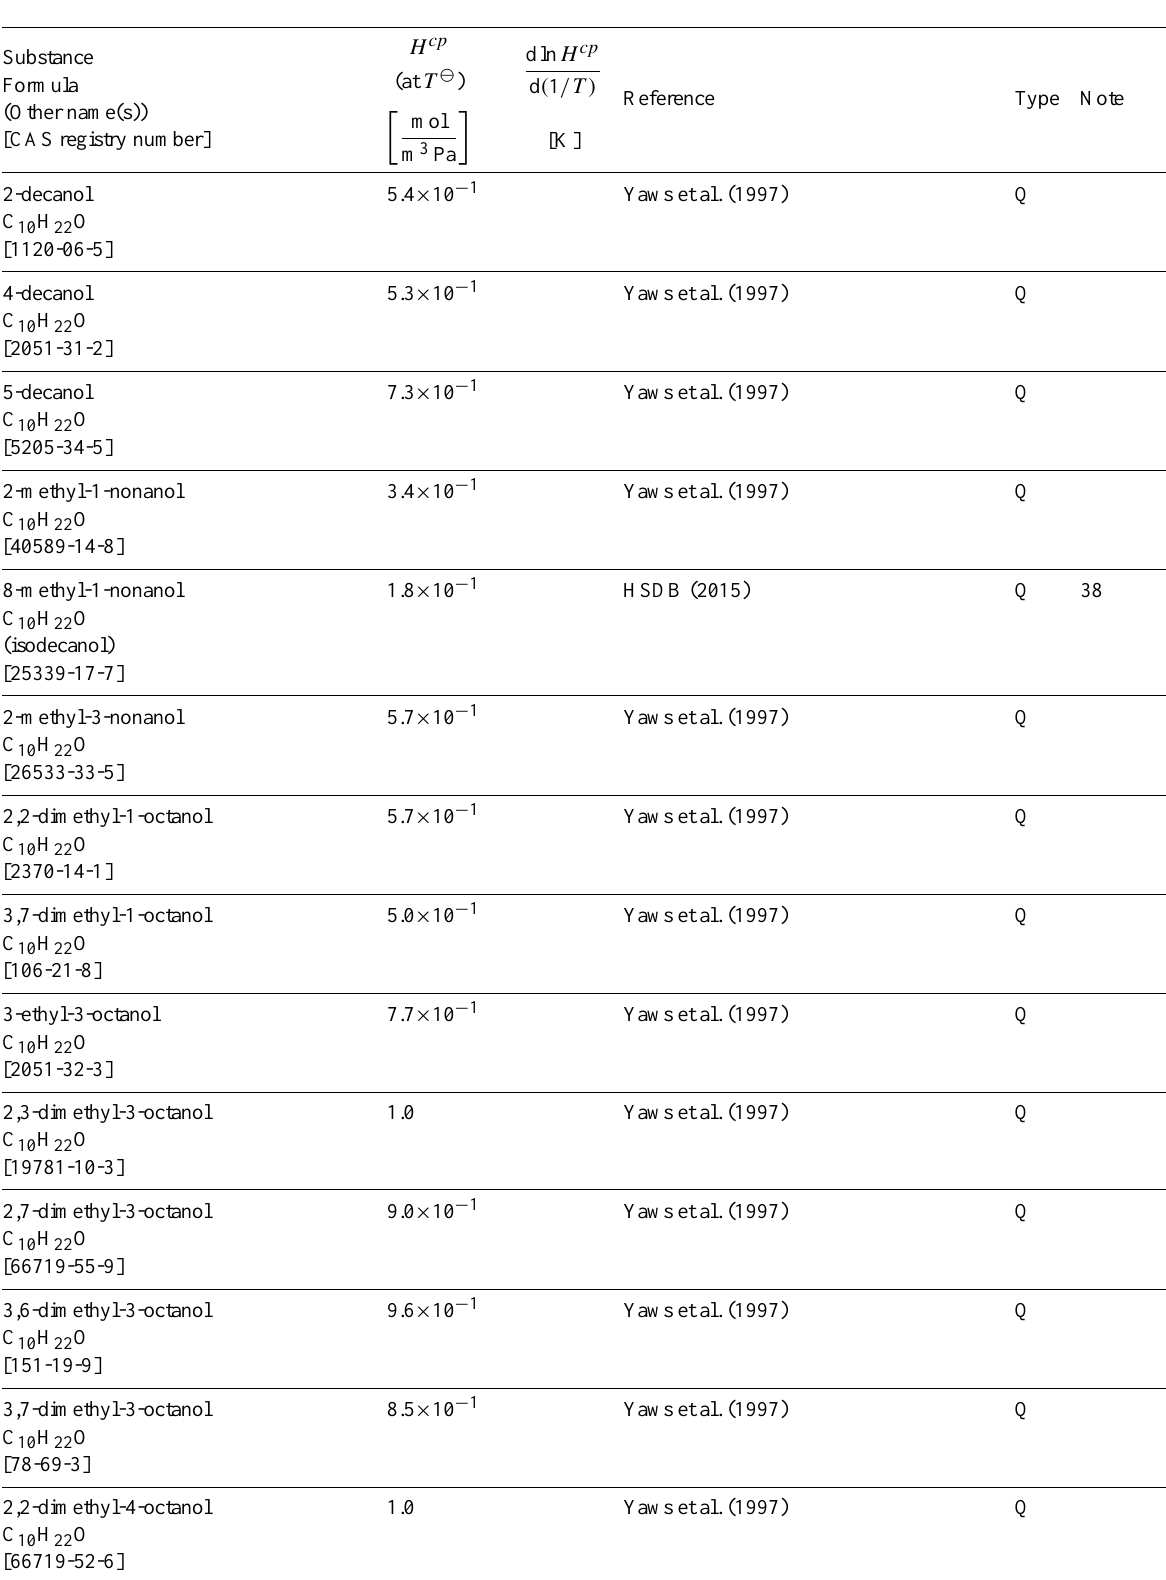
Table 6: Henry’s law constants for water as solvent